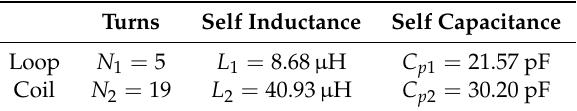
Table 2. Electrical parameters of the inductors.